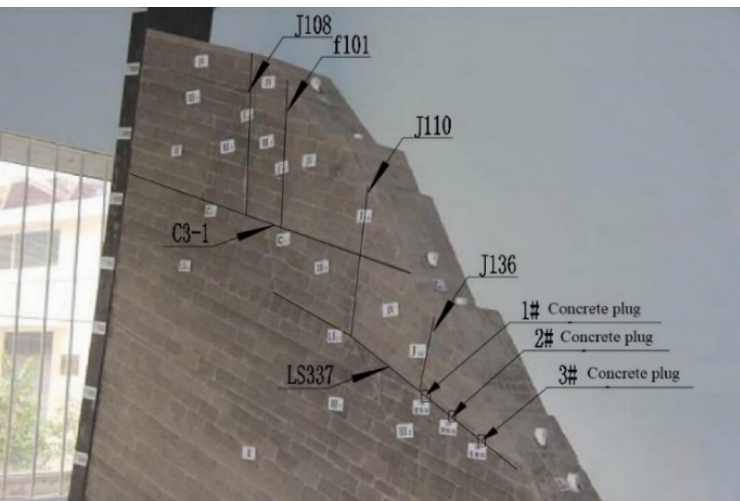
Figure 7. Two-dimensional geomechanical model of slope.